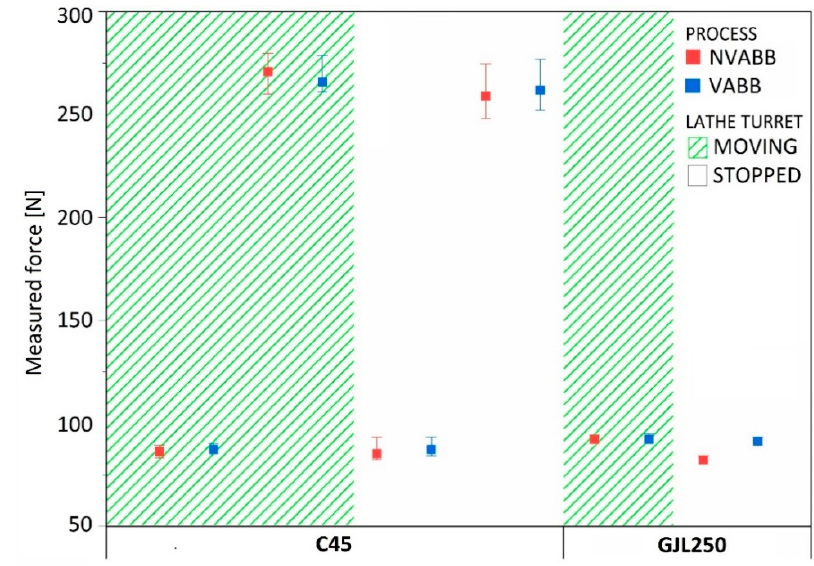
Figure 3. Average, maximum, and minimum forces recorded during the tests.